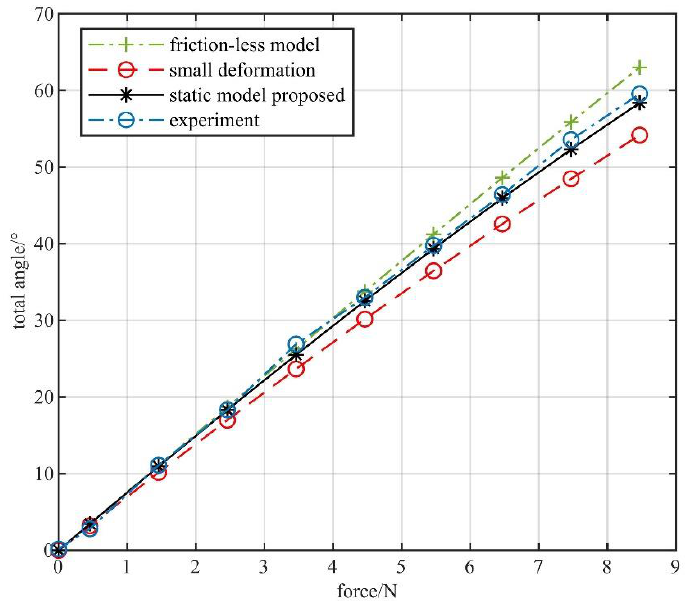
Figure 12. Bending angle-cable force relationship of NCR.